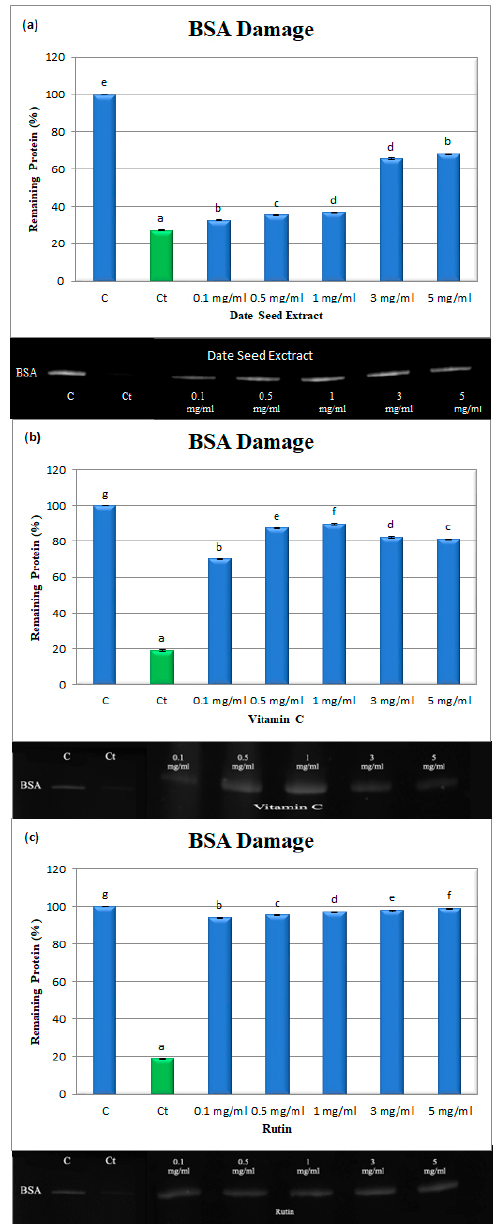
Figure 4. Densitometric analysis and SDS-PAGE of the effects of ( a ) DSE, ( b ) V.C., and ( c ) rutin, on the oxidative damage of BSA. C: BSA, Ct: BSA + AAPH, BSA + AAPH + DSE, V.C., or rutin at concentrations of 0.1–5 mg/mL. C and Ct are cropped from a different gel Data are expressed as the mean ± SD; n = 3. Different letters in a column denote significant differences, p < 0.05.